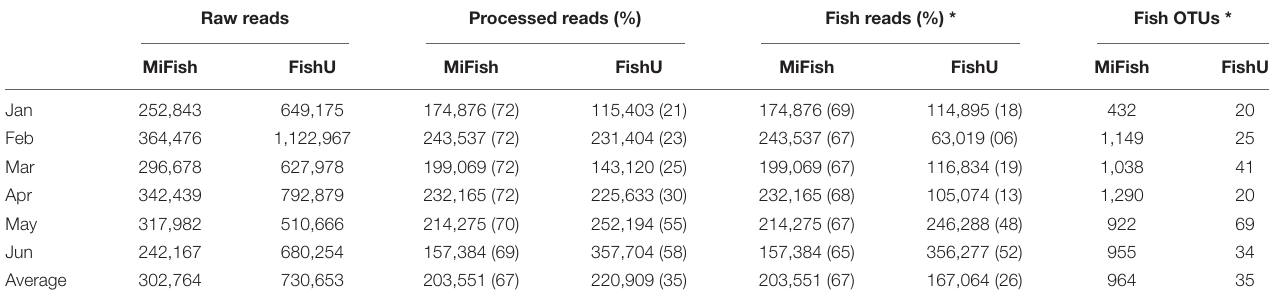
TABLE 4 | Summary of read numbers generated from three primers during the bioinformatics